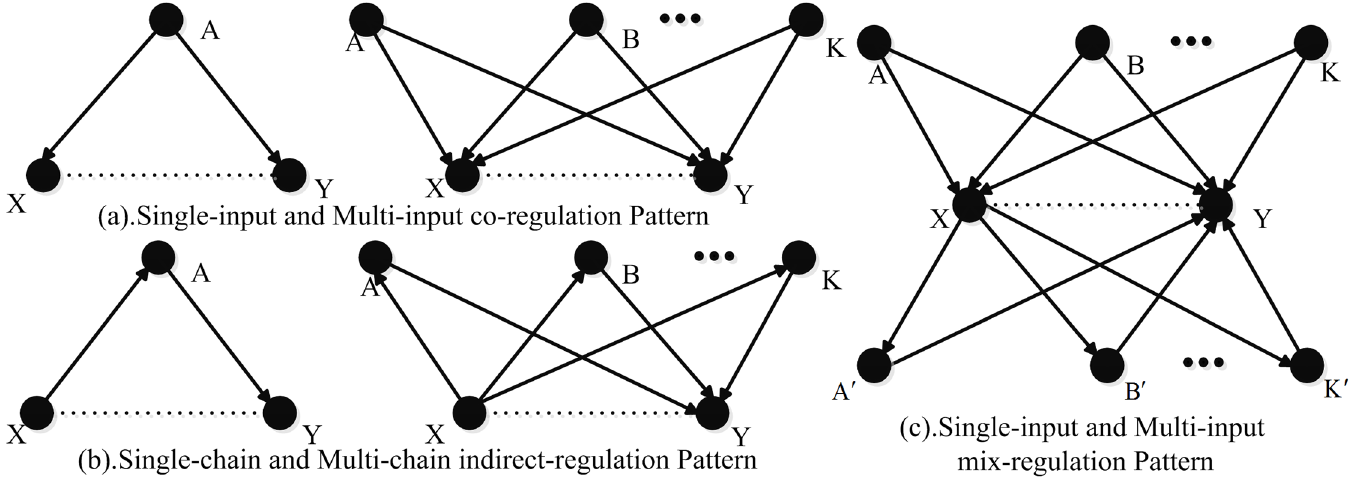
Fig 1. Diagram of candidate patterns. ( a ) Co-regulation pattern consists of single-input and multi-input co-regulation. ( b ) Indirect-regulation pattern consists of single-chain and multi-chain indirect-regulation. ( c ) Mix-regulation pattern includes both co-regulation and